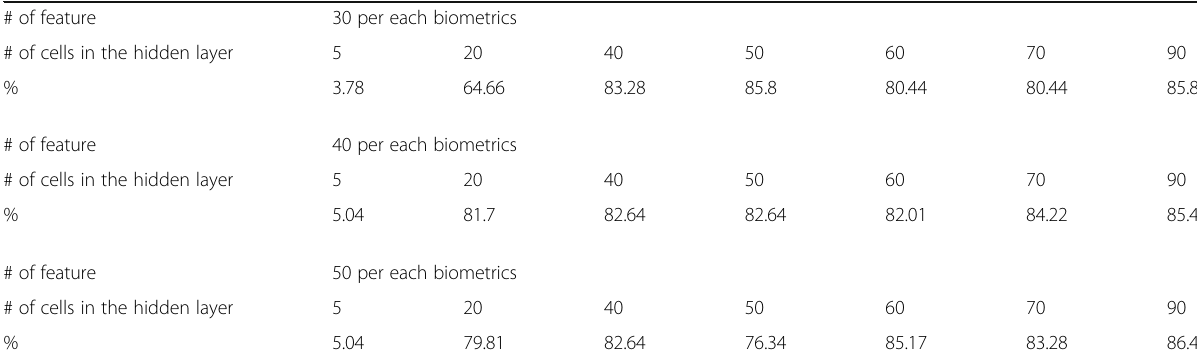
Table 5 Feature-level fusion with eigenfeatures (#feature 30 – 40 – 50)